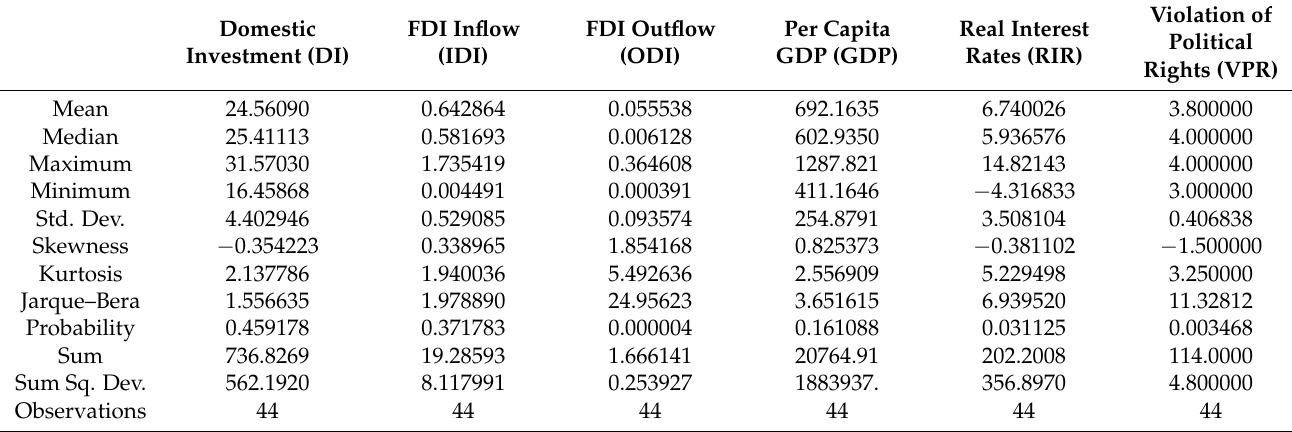
Table A1. Summary statistics of the data